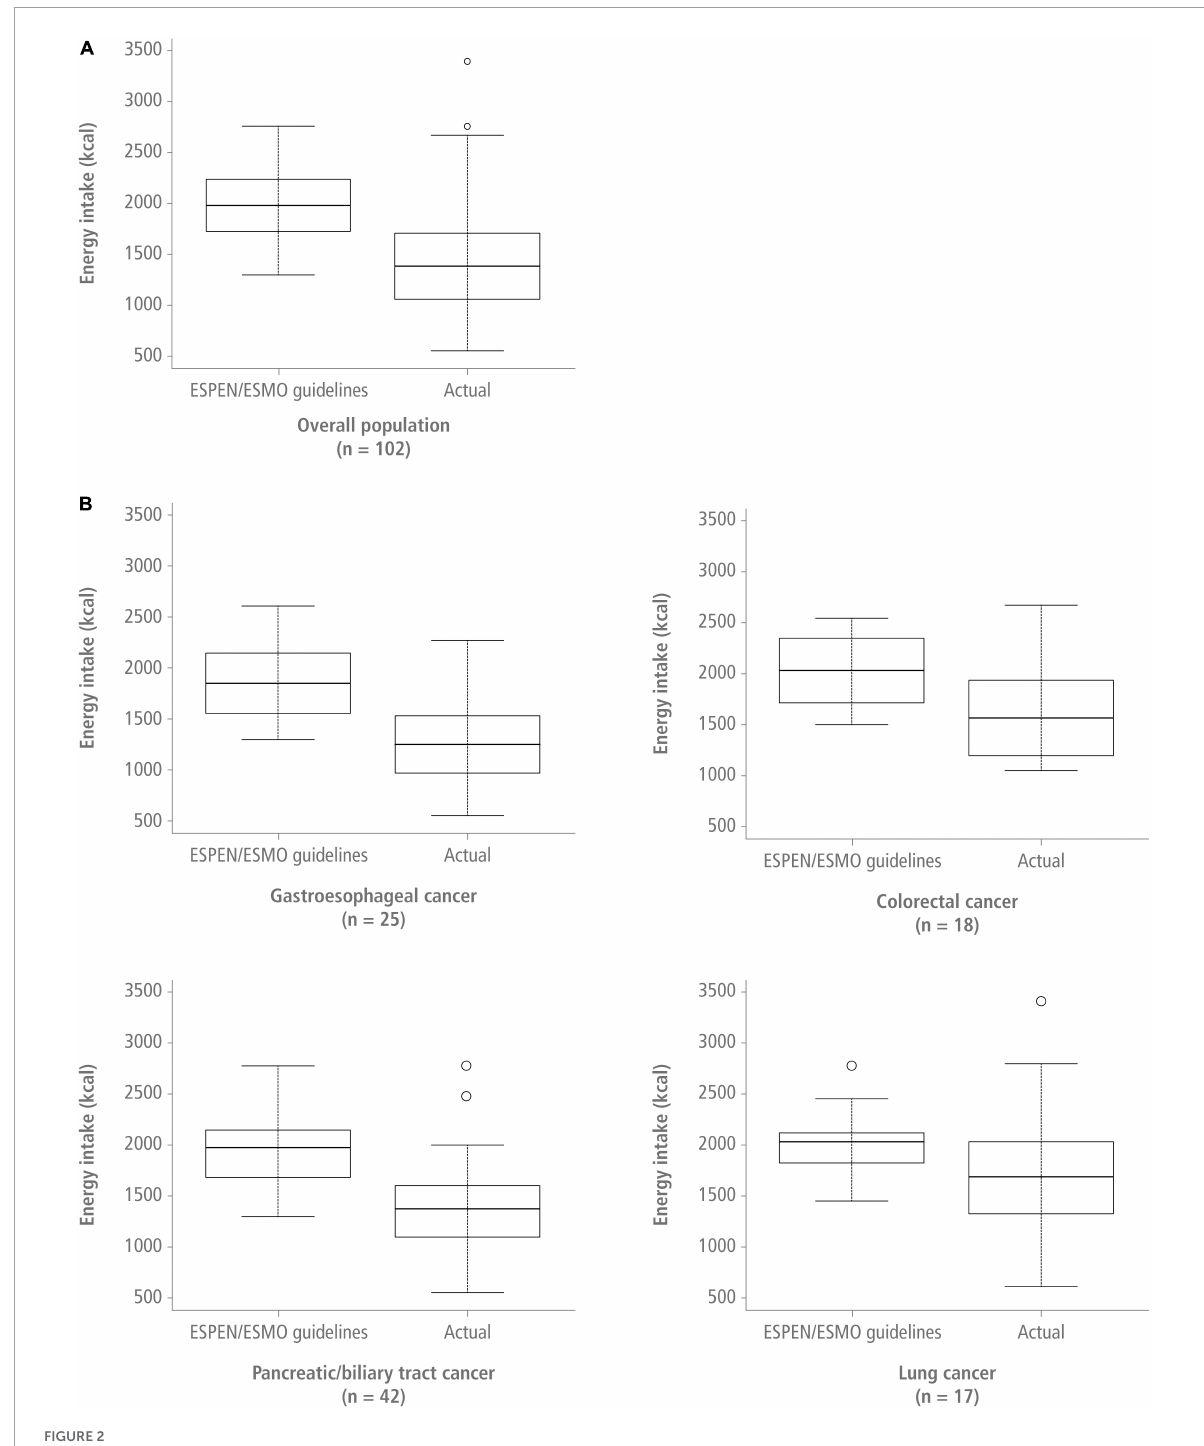
2,000 patients with cancer, which reported a 51.1% prevalence of malnutrition (27). Furthermore, we show a high prevalence of cachexia, which was present in almost 70% of patients.